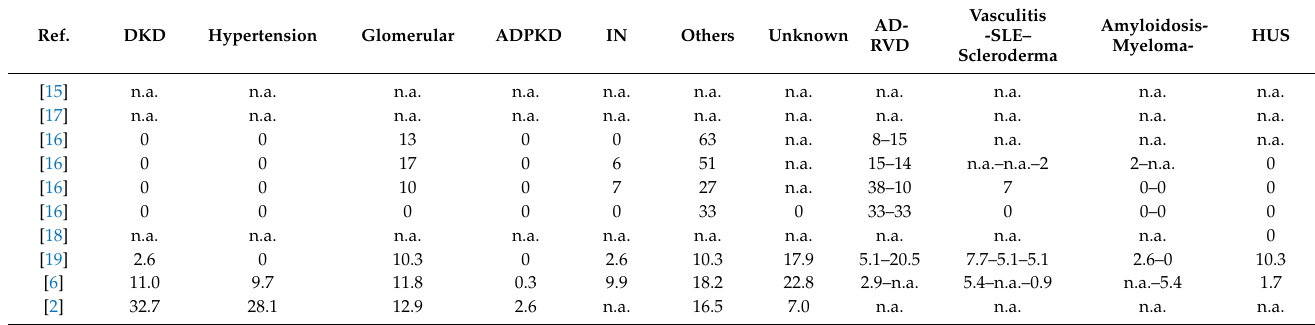
Table 2. Prevalence of primary kidney disease (%) in patients with the recovery of kidney function ( N =